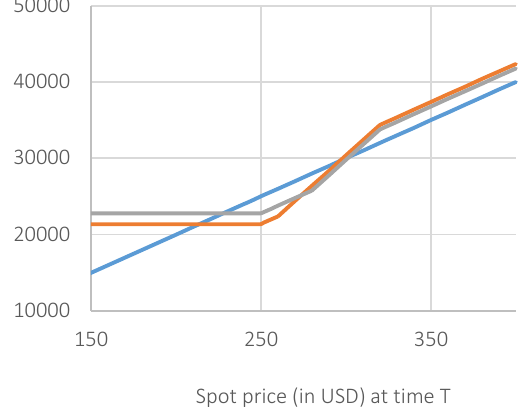
Source: Own calculations.